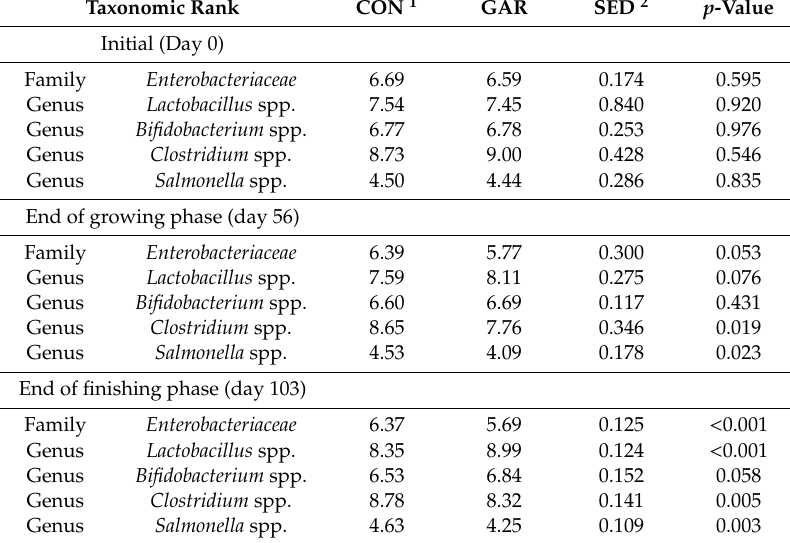
Table5. Thee ff ectofdietaryadditionof Allium spp. extractontheintestinalcontentsof Enterobacteriaceae , Lactobacillus spp., Bifidobacterium spp., Clostridium spp., and Salmonella spp. (log10 number of copies DNA / g feces) in growing-finishing